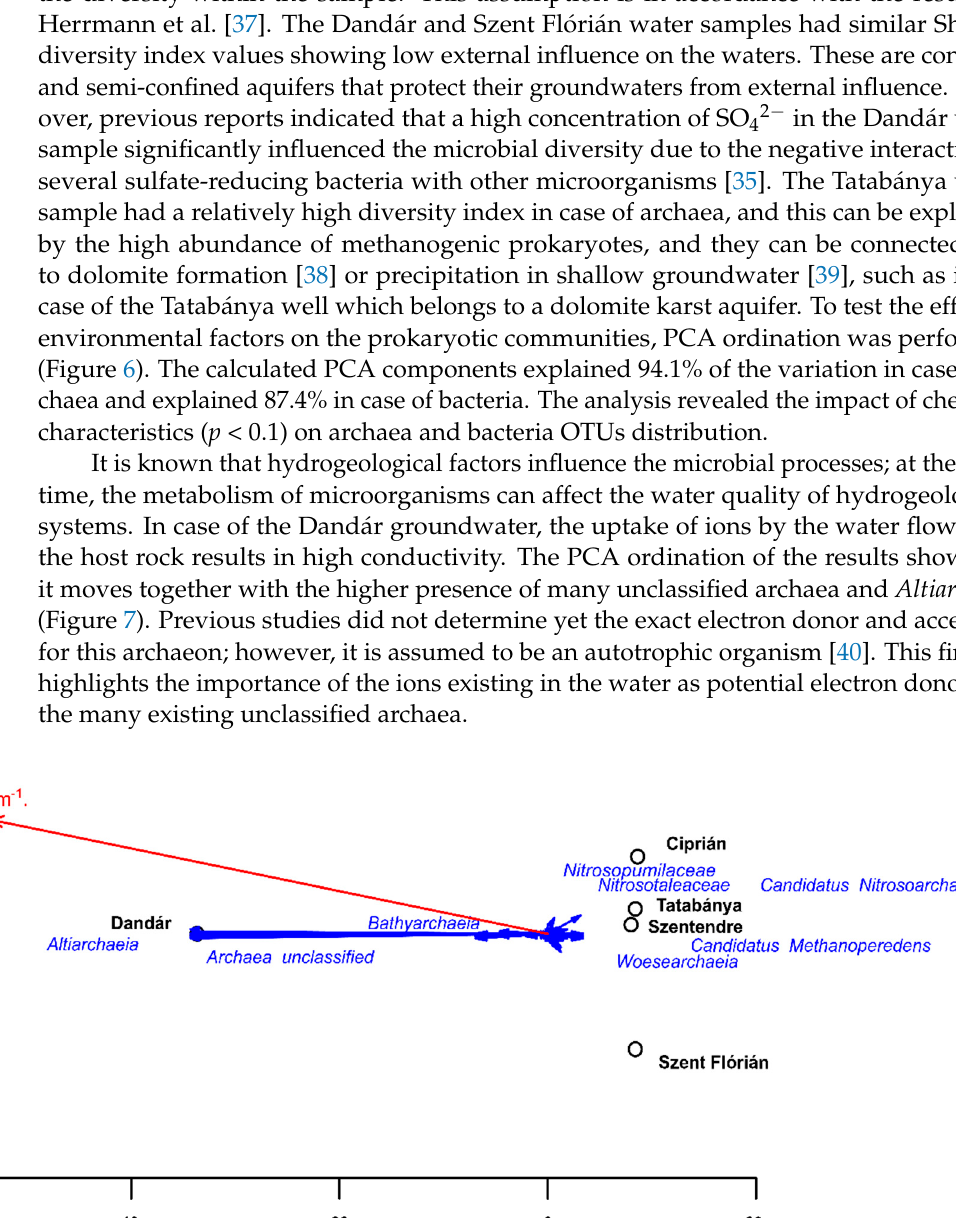
Figure 8. PCA ordination of the water samples based on bacterial community structure and environmental parameters.